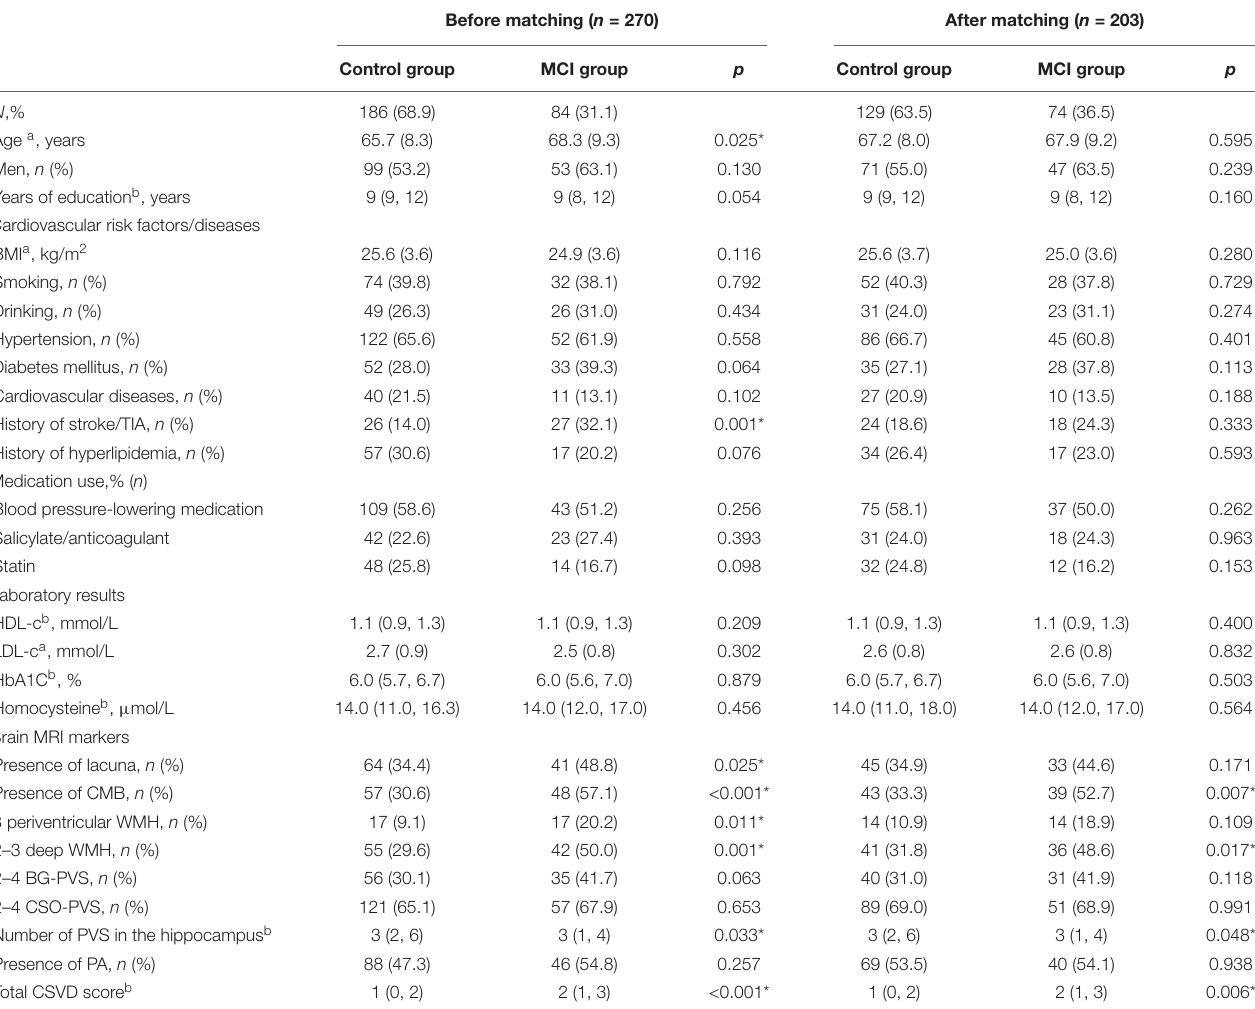
TABLE 1 | Demographic data and clinical characteristics before and after propensity score